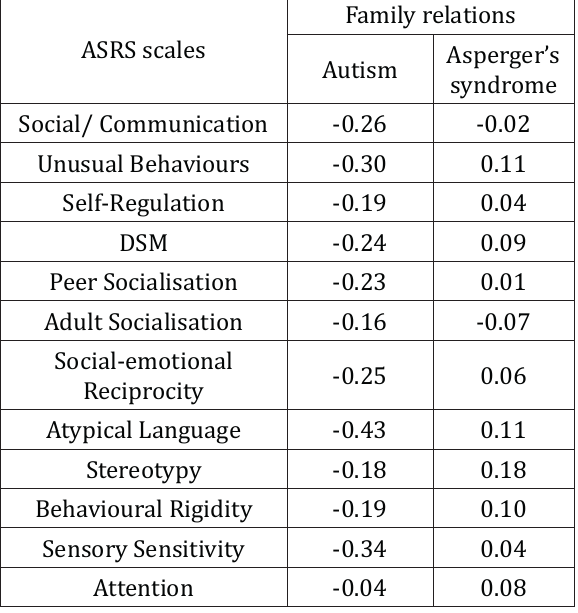
Table 2. Correlation coefficients calculated between the assessment of family relations and ASRS scales in the group of mothers of children with autism and Asperger's syndrome